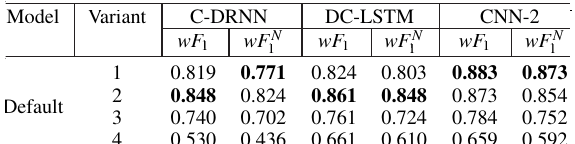
Fig. 5. Confusion matrix of C-DRNN on the OCA dataset with combined screw and unscrew cover panel.